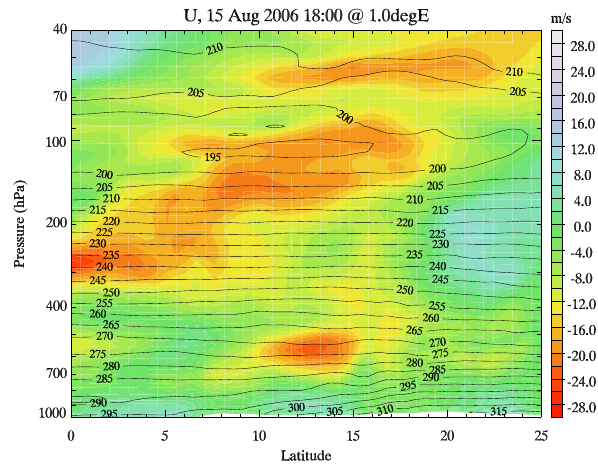
Fig. 7. Time series of NO x , wind velocity and direction in (a) , NO, NO y , HCHO, and pressure altitude in (b) , and NO, CO, O 3 , and pressure altitude in (c) for the Falcon flight on 15 August 2006. Sequences with elevated NO mixing ratios ( ≥ 0 . 3nmolmol − 1 ) are labelled 1–7 in red.